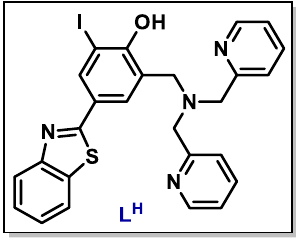
Figure 2. Chemical structure of the bifunctional ligand L H with p53 anti-aggregation effect.